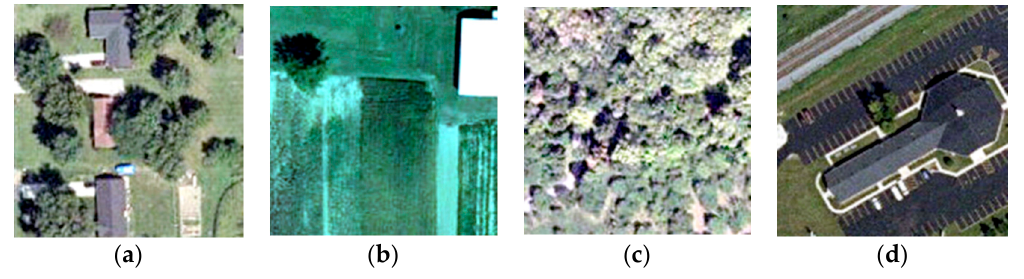
Figure 9. USGS dataset: ( a ) residential; ( b ) farm; ( c ) forest; and ( d ) parking lot.